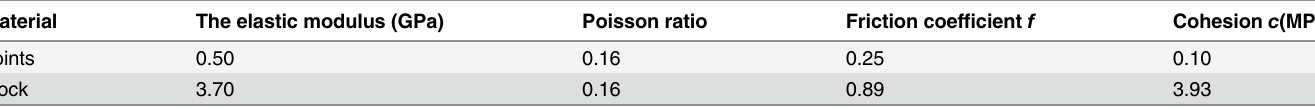
Table 2. The parameters of the joints and the rock Material The elastic modulus (GPa)